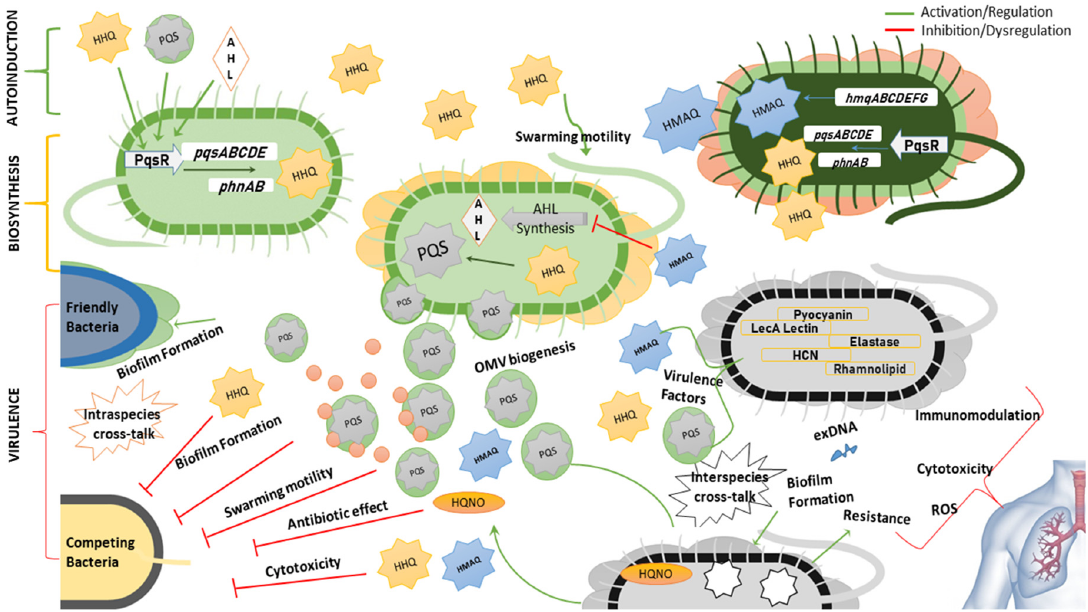
Figure 5. Summary of links between biosynthesis, auto-induction and virulence mediated by alkylquinolone quorum sensing molecules. Abbreviations: PQS—Pseudomonas Quinolone Signal,